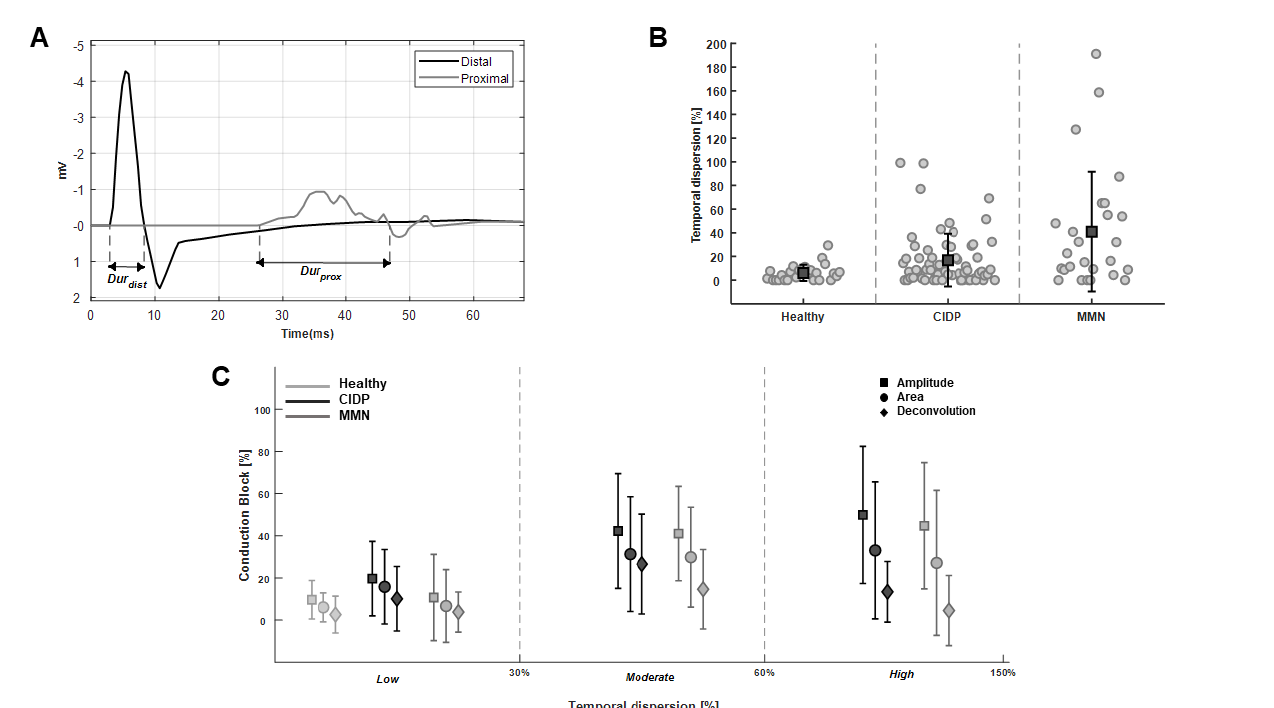
Figure 5. Investigation of temporal dispersion (TD) of CMAPs. ( A ) Definition of the measurement of the duration of the CMAPs in a case recorded from a MMN patient. ( B ) TDs of the CMAPs of our dataset (individual values indicated by circles; mean indicated by a square and standard deviation by the length of bars), grouped with respect to the pathology. ( C ) CB estimation with either standard (amplitude and area) or deconvolution methods, as a function of TD